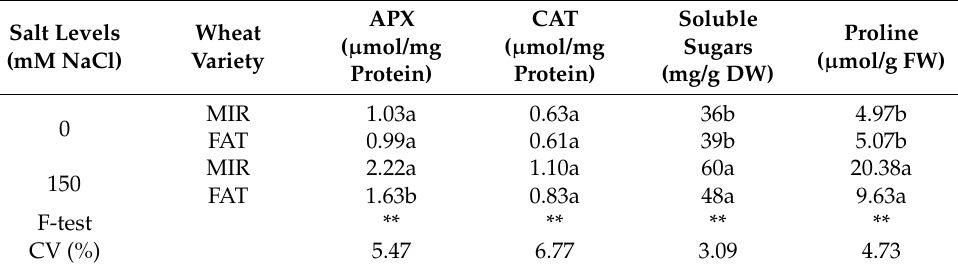
Table 1. Effect of 150 mM NaCl on APX ( µ moL/mg protein), CAT ( µ moL/mg protein) activity in leaves of the salt-tolerant Mirbashir-128 and salt-sensitive Fatima wheat genotypes after 10 days of salt treatment.